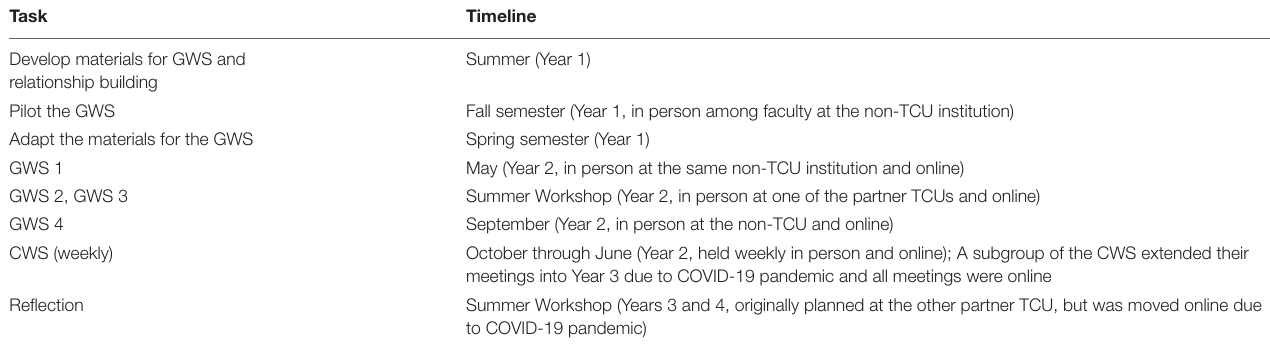
TABLE 1 | Timeline of the RPGP program.